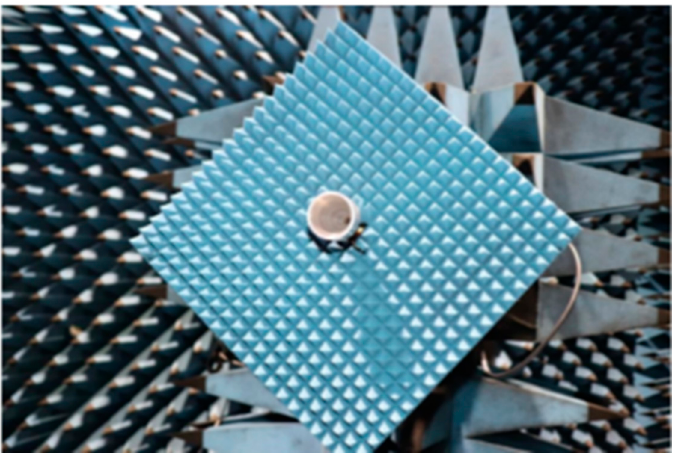
Figure 15. Photograph of the radiation pattern measurement setup of horn antennas at SAC-ISRO facility.